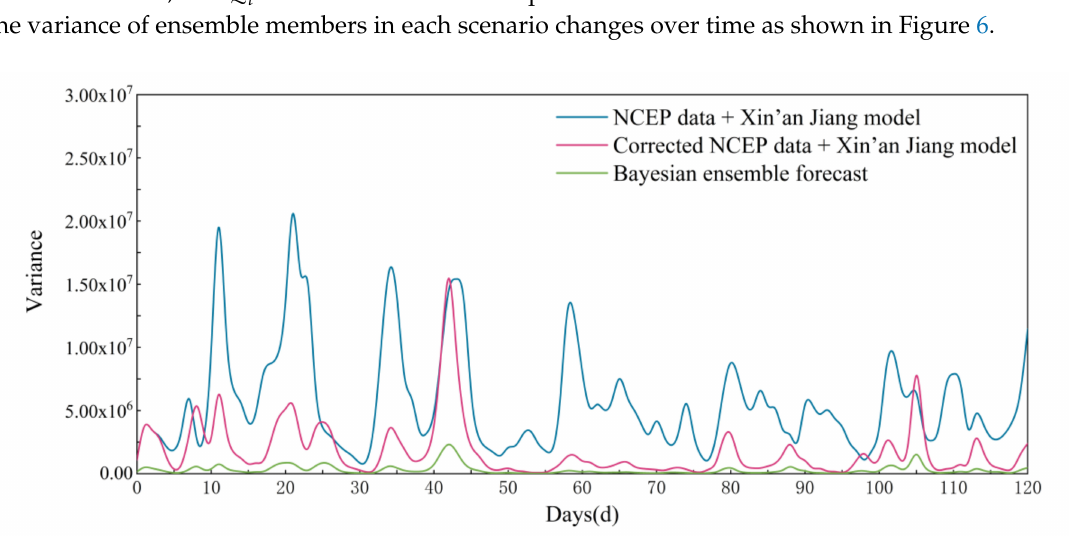
Figure 6. The variance of ensemble flow forecast members at di ff erent moments of the 2017 flood season under di ff erent